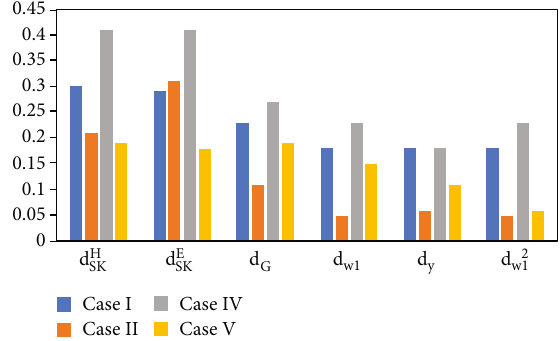
Figure 2: Graphical comparison of distance measures given in Table